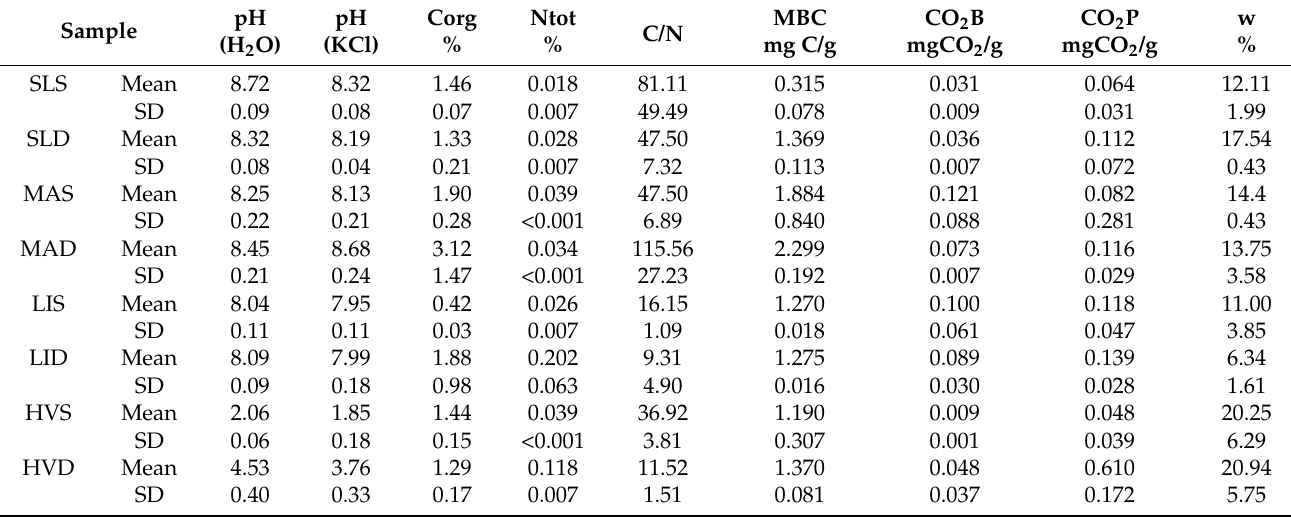
Table 2. Chemical and microbiological properties of the